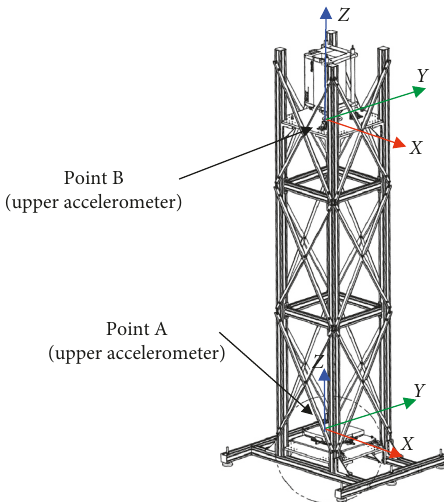
Figure 11: OTS and the two sets of Cartesian coordinate systems used for computing transmissibility functions.